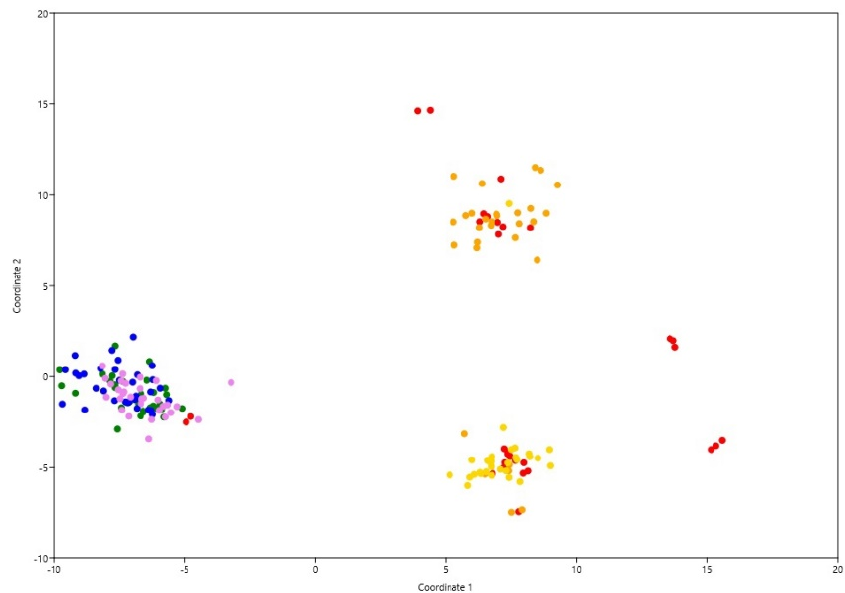
Figure 3. Distribution of individuals in the studied populations of Pinus sylvestris L. of the Middle Urals using UMAP.